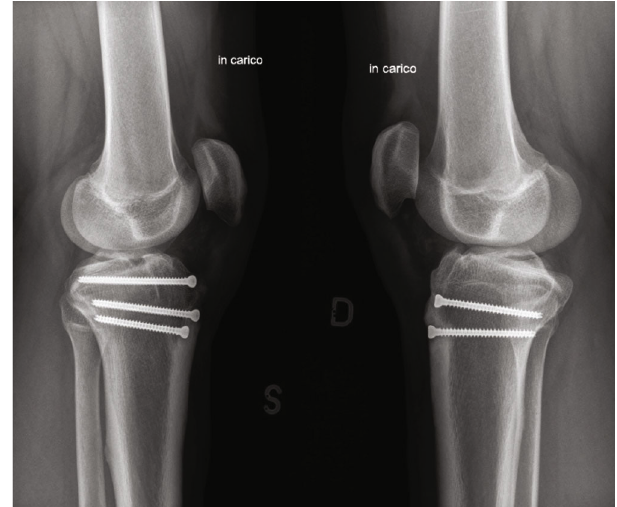
Figure 2: Post-operative imaging at 4 months demonstrating anatomic reduction and fi xation with cannulated full threaded 4.5 mm